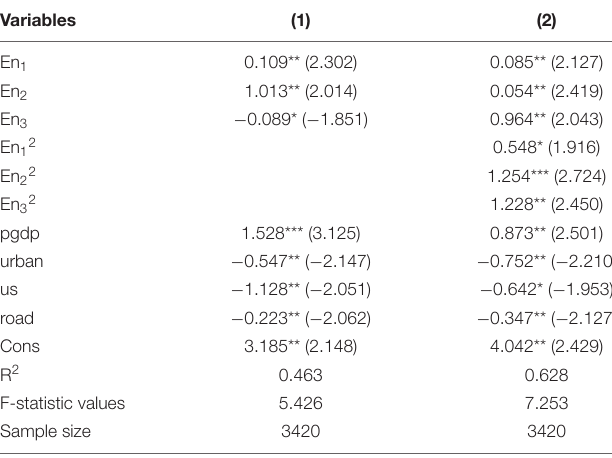
TABLE 2 | Test results for linear and non-linear effects of environmental regulation on urban green innovation.